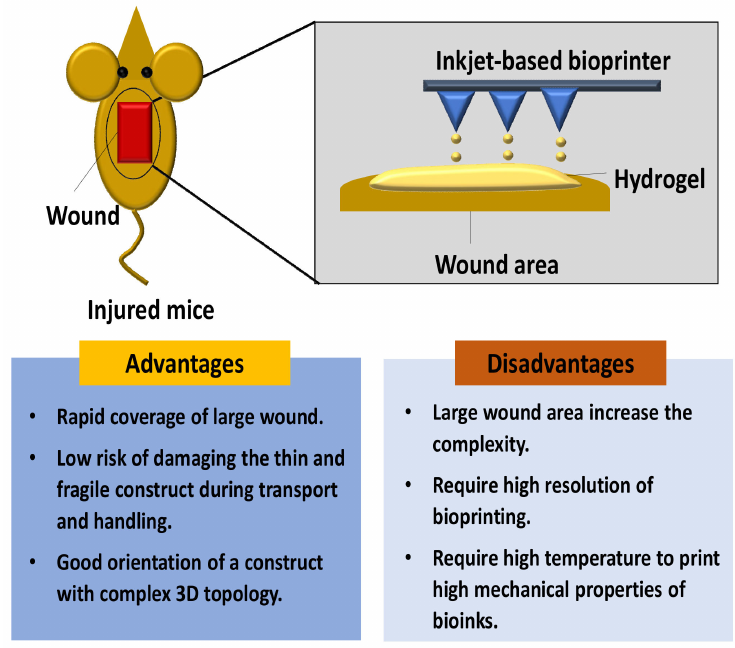
Figure 6. In situ bioprinting for the wound by using inkjet-based bioprinting